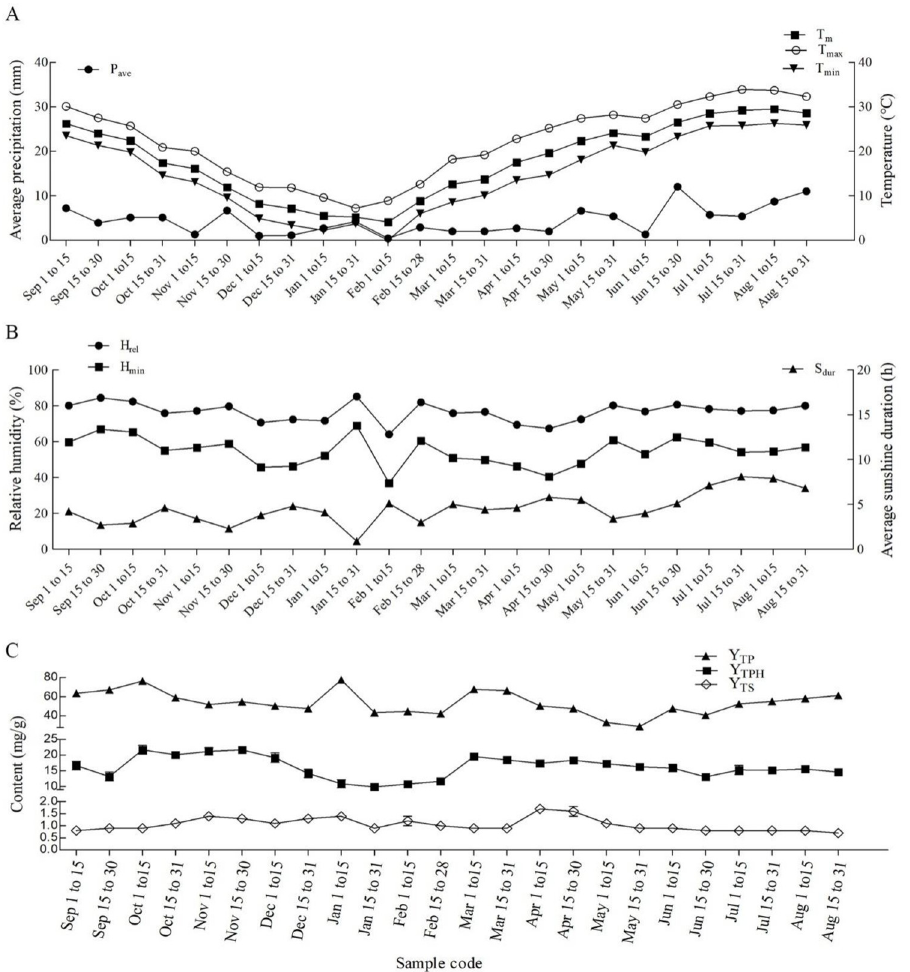
Fig 1. Contents of secondary metabolites in T . hemsleyanum and data of climatic factors. (A) Semi-monthly variation of precipitation and temperature; (B) Semi-monthly variation of humidity and sunshine duration; (C) Semi- monthly accumulation of three major metabolites. P ave , average precipitation; T m , mean temperature; T max , average maximum temperature; T min , mean minimum temperature; H rel , average relative humidity; H min , average minimum relative humidity; S dur , average sunshine duration; Y TPH , content of phenolic compounds, Y TS , content of sterols, Y TP , content of